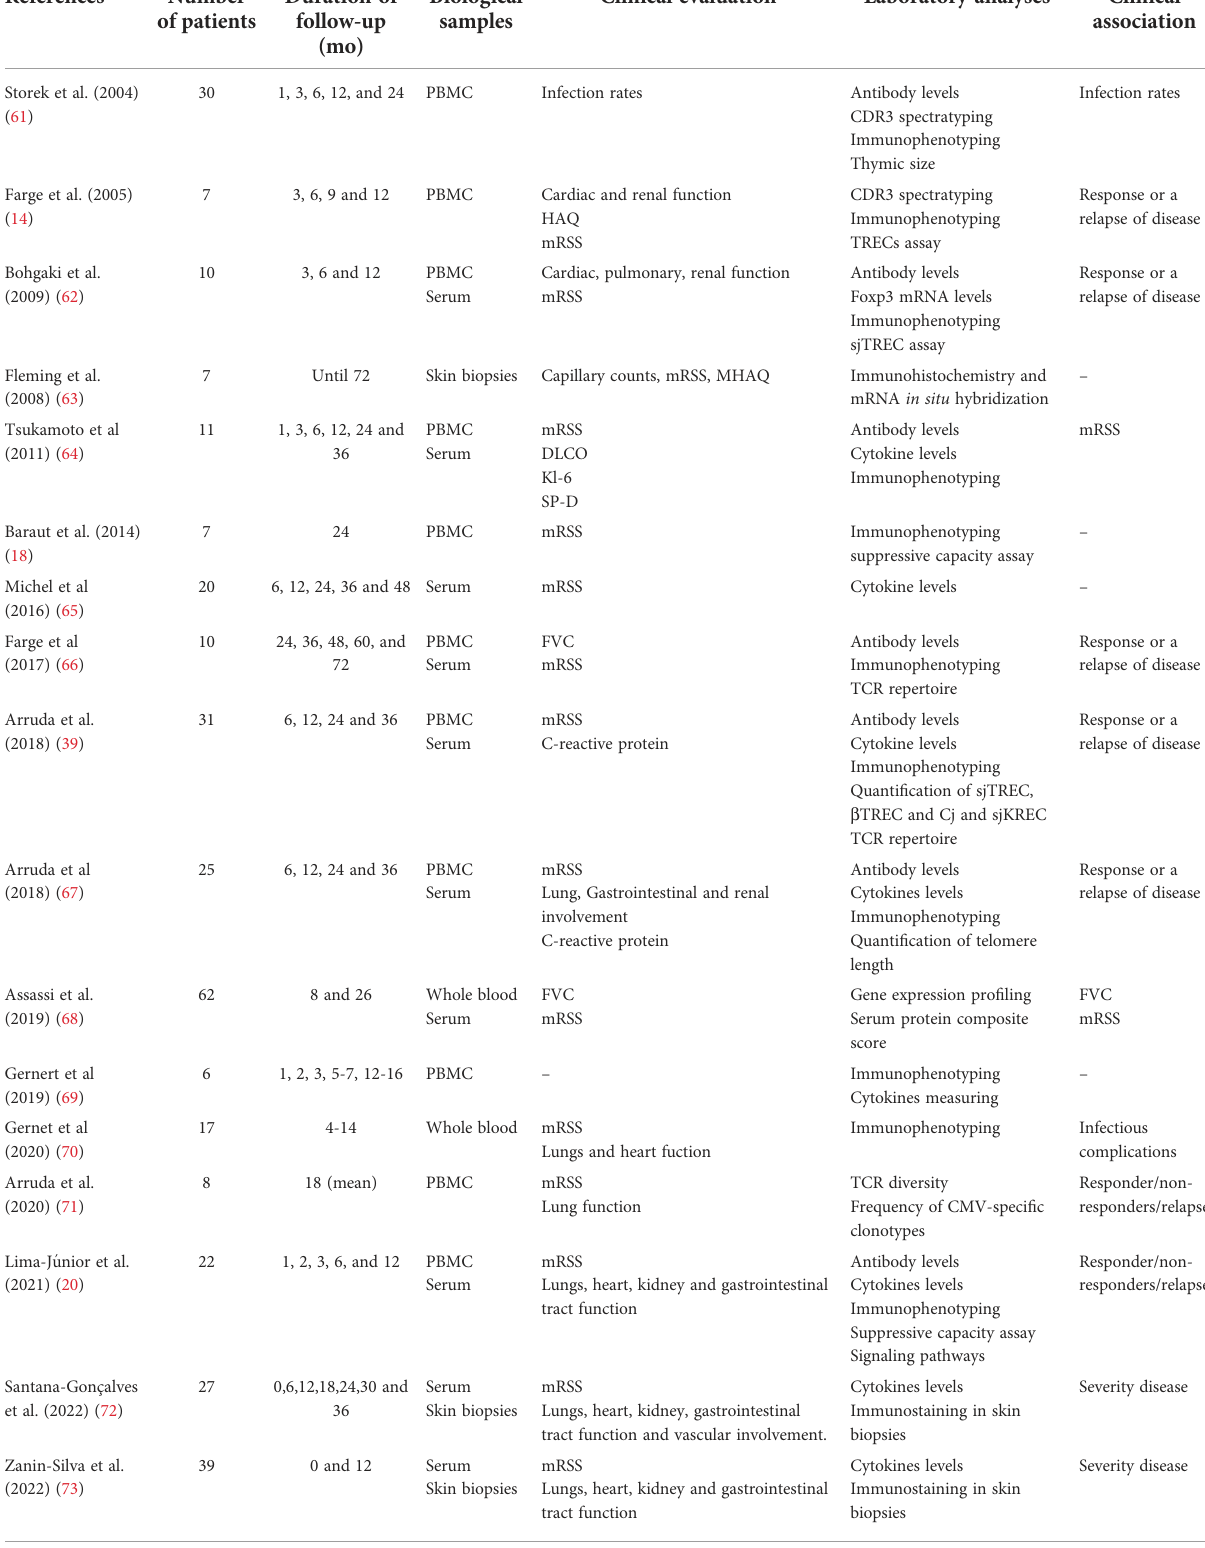
TABLE 2 Overview of studies that evaluated immune reconstitution and clinical outcomes in SSc patients treated with